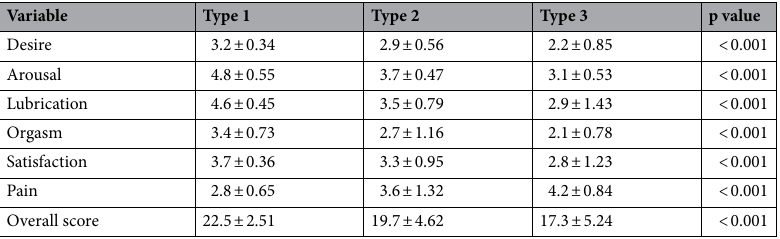
Table 2. Association of the FGMtypes with the mean FSFI scores. The total score ranges between 2 and 36, and sexual dysfunction is considered in patients with a total score lower than 26.0 FGM: female genital mutilation; FSFI: Female Sexual Function